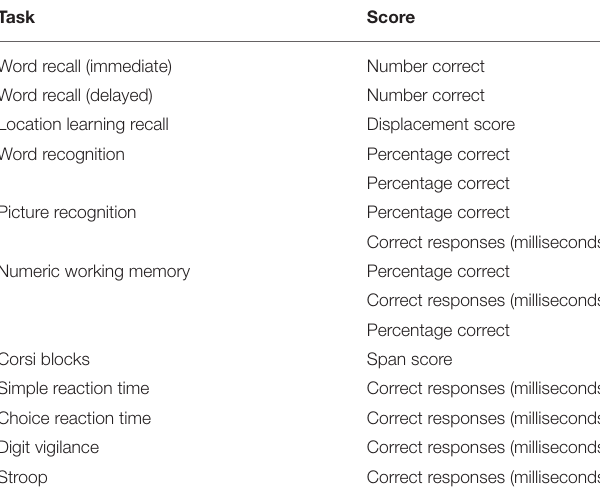
TABLE 1 | COMPASS tasks